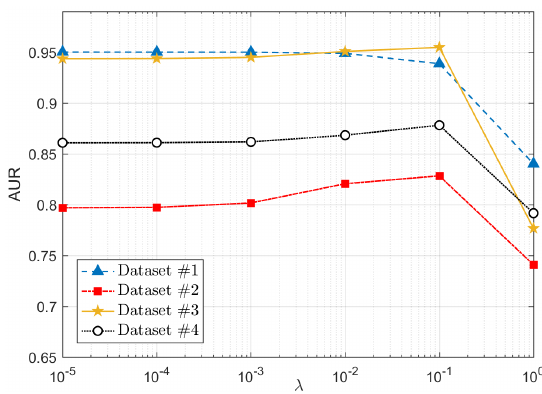
Figure 7. Influence of parameter λ on the proposed